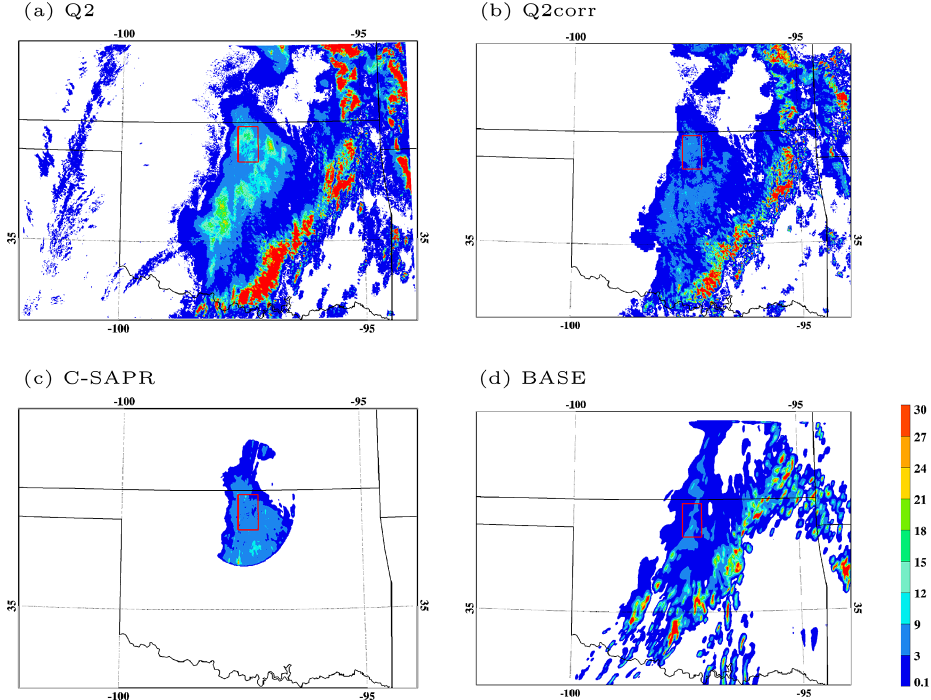
Figure 9. Surface precipitation rate (mm h − 1 ) from Q2 at 14:00UTC (a) , gauge-corrected Q2 ( b ; see text) from C-SAPR at 13:40UTC (c) , and in the BASE simulation at 13:00UTC (d) . Red rectangles bound the Citation aircraft flight legs examined here.